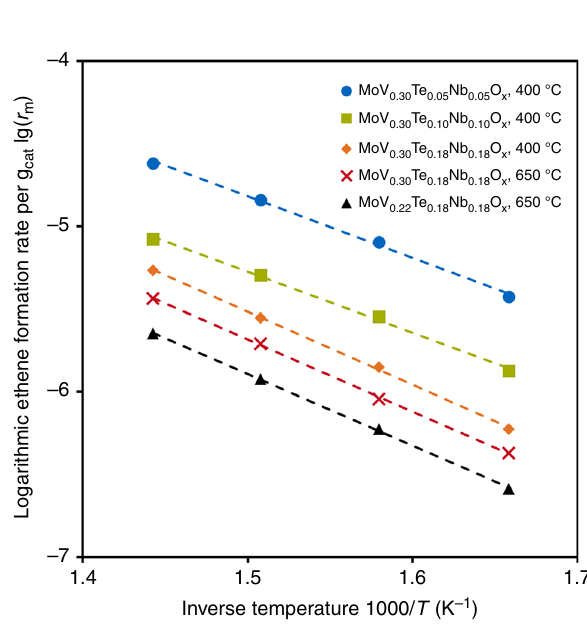
Fig. 2 Arrhenius plot for ethene formation over selected MoVTeNbO x samples. Temperatures of the different thermal treatments are given in the legend. Activity was normalized to catalyst mass. T = 330 – 420 °C, p = 1 bar ( a ), weight hourly space velocity (WHSV) = 14.3 – 17.6 h −